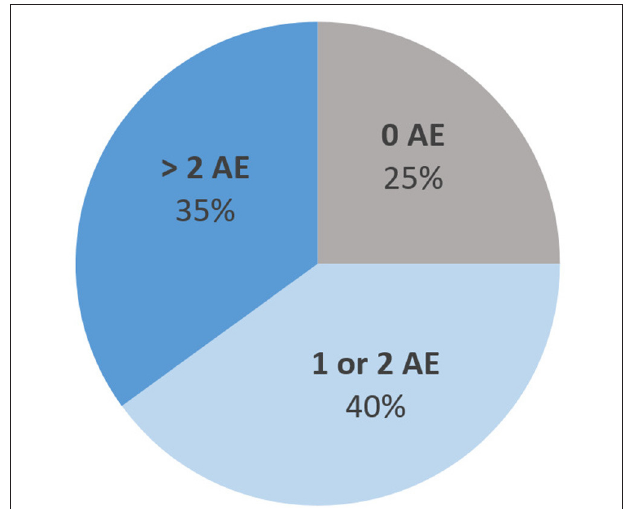
FIGURE 5 | Distribution of the maximum number of concomitant adverse events (AE) per hospitalization